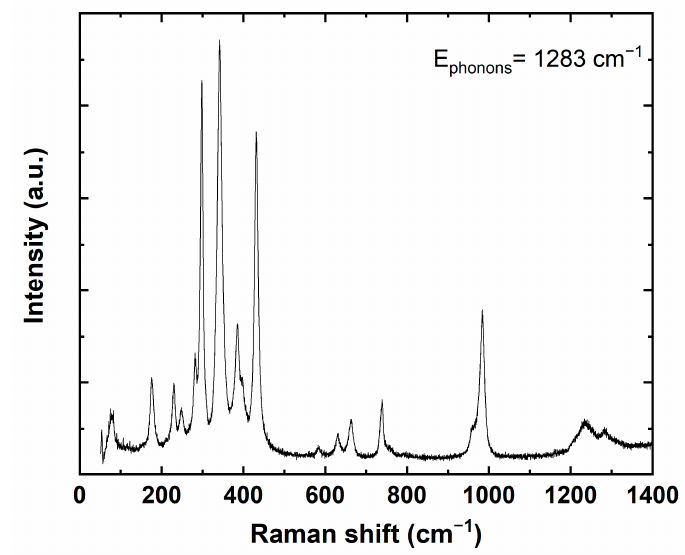
Figure 11. Raman spectrum of the LYSB crystal.